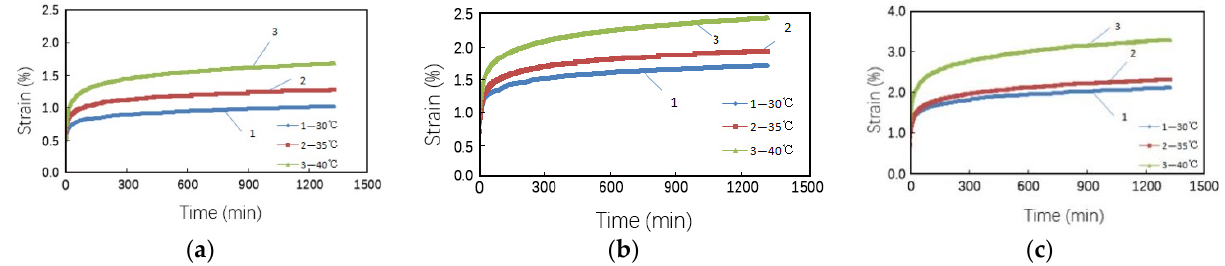
Figure 5. Effect of the temperature on the creep strain with load change: ( a ) constant load of 40% of the stress; ( b ) constant load of 50% of the stress; ( c ) constant load of 60% of the stress.